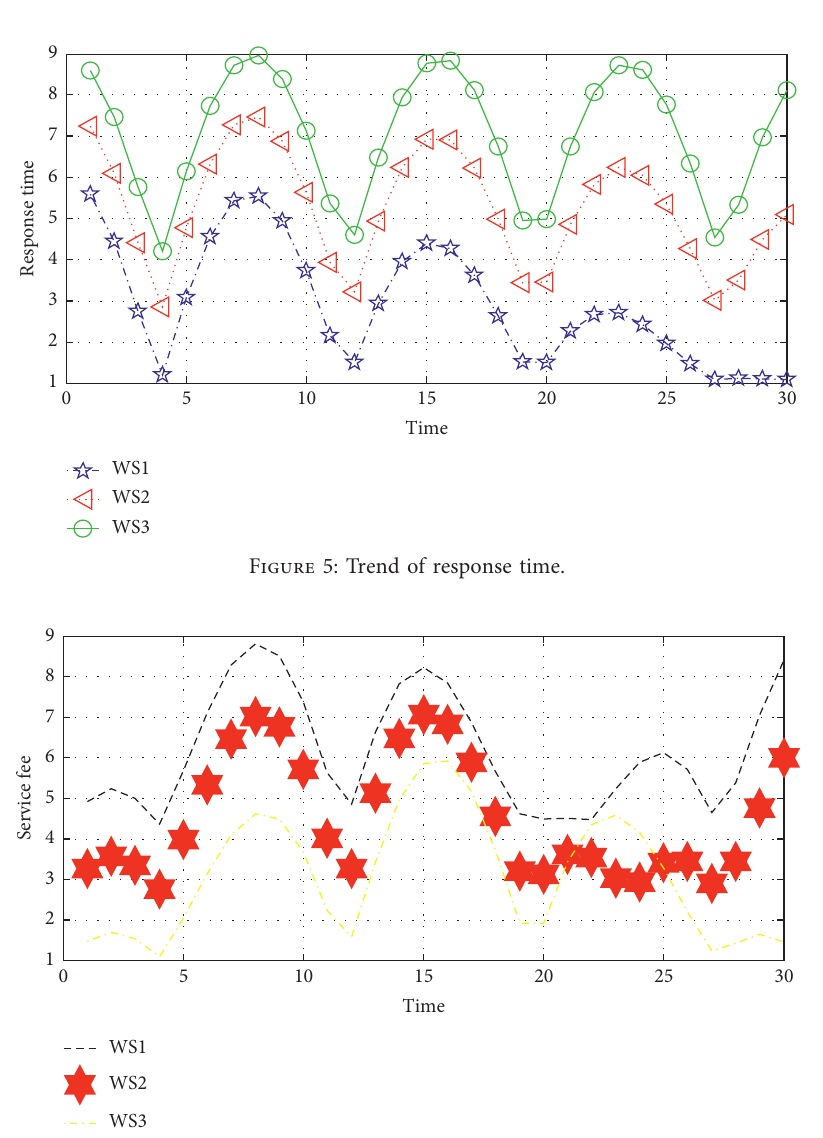
Figure 6: Trends in service